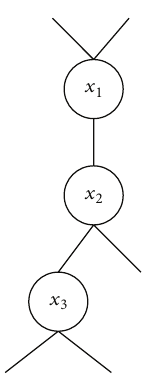
Figure 1: Portion of a